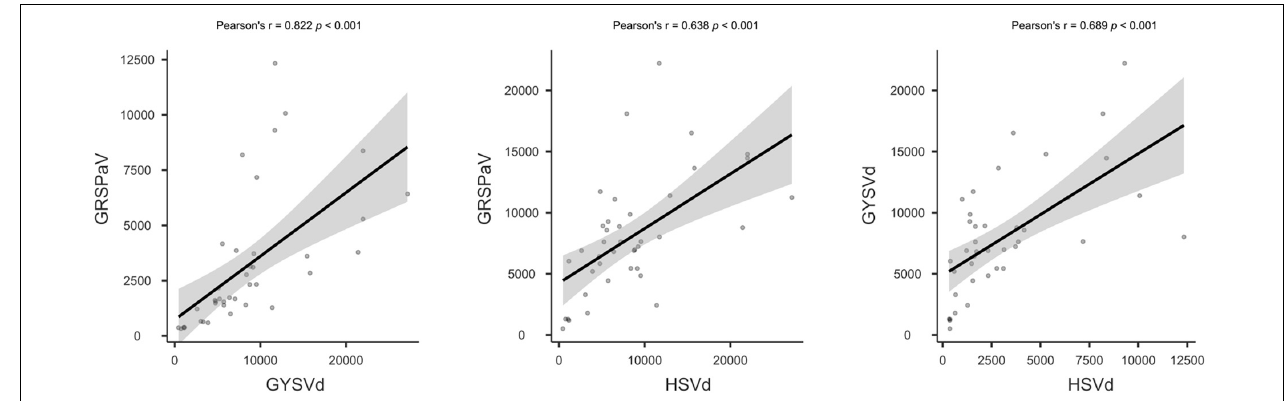
FIGURE 4 | Correlation plot of vsiRNA reads amounts specific for GRSPaV, GYSVd, and HSVd. The statistical analysis was performed with Jamovi v.1.6.